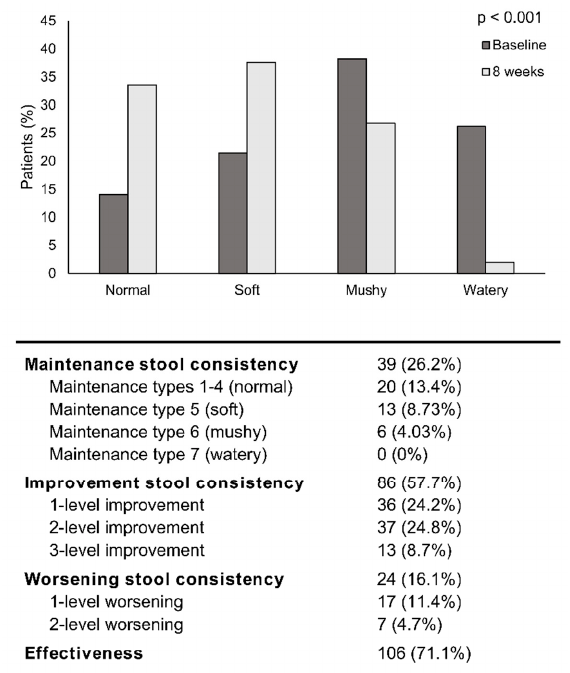
treatment. Changes in stool consistency from baseline to week 8 were statistically significant ( p < 0.001). Figure 3. Change in stool consistency after 8 weeks of oligomeric enteral nutrition (OEN). The bars the OEN protocol in improving stool